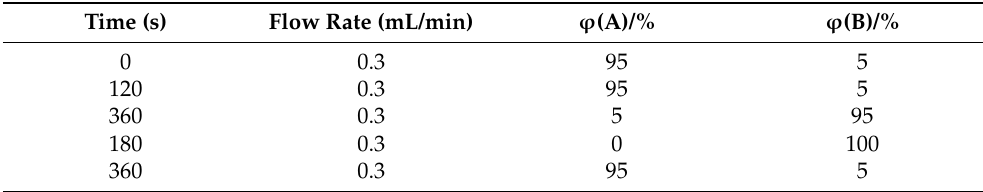
Table 1. Gradient elution procedure of the pentostatin. Time (s) Flow Rate (mL/min) ϕ (A)/% ϕ (B)/% 0 0.3 95 5 120 0.3 95 360 0.3 5 95 180 0.3 0 100 360